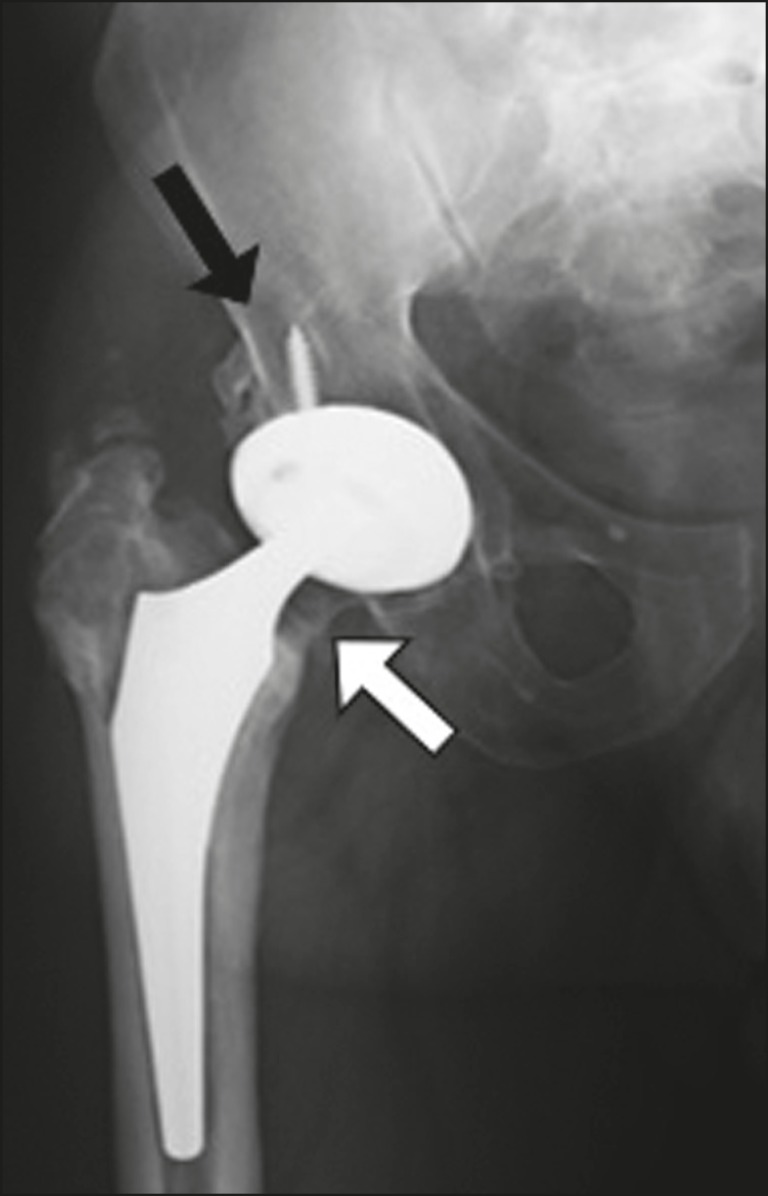
Anteroposterior X-ray of the right hip showing a total bipolar prosthesis and minor resorption (osteolysis—black arrow) of a screw in the acetabular component. Grade IV heterotopic ossification between the femur and the lower border of the acetabulum (white arrow). Cortical thickening without periosteal reaction (stress shielding) is also observed.